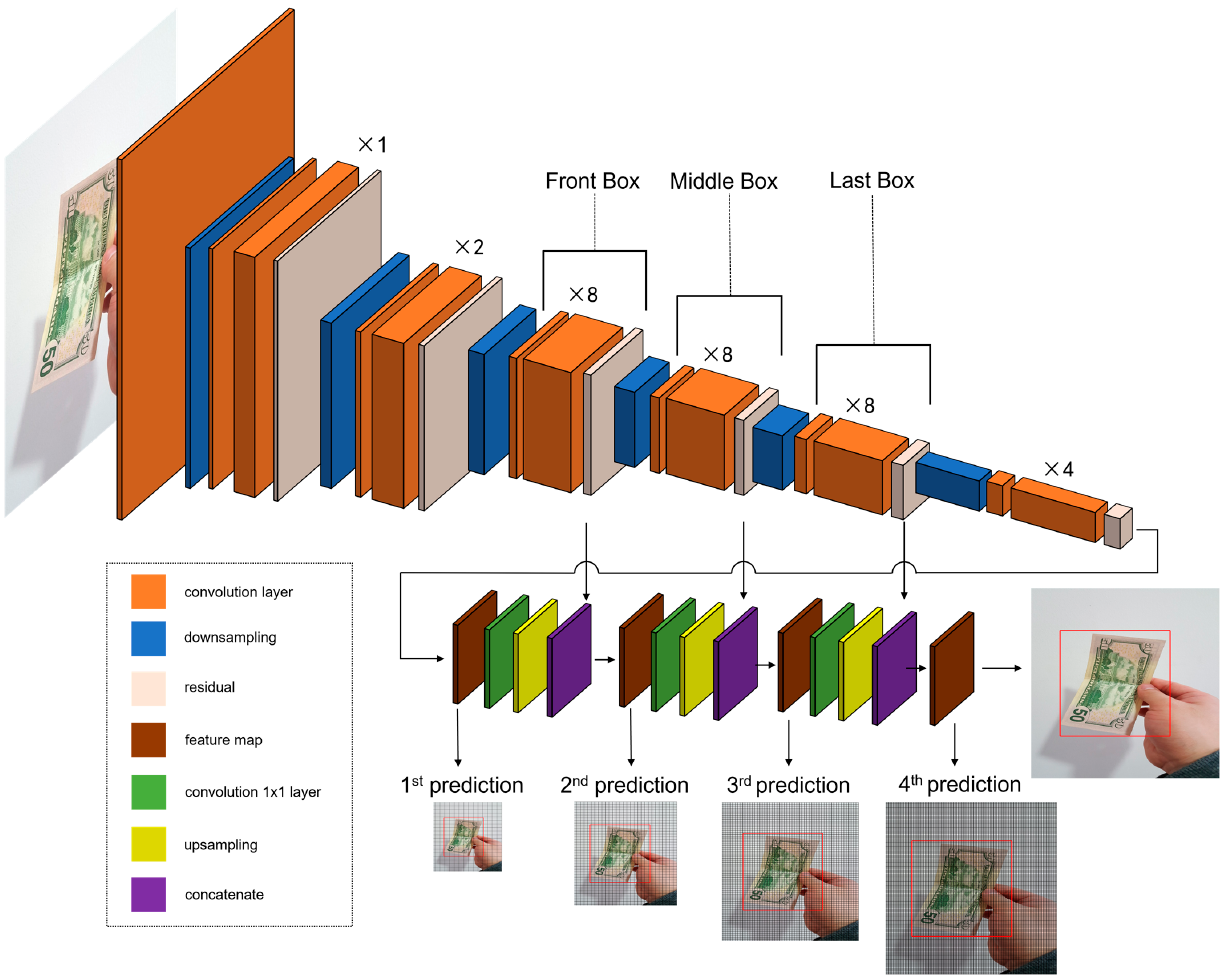
Mathematics 2023 , 11 , x FOR PEER REVIEW Figure 3. Structure of the MBDM. Figure 3. Structure of the MBDM.